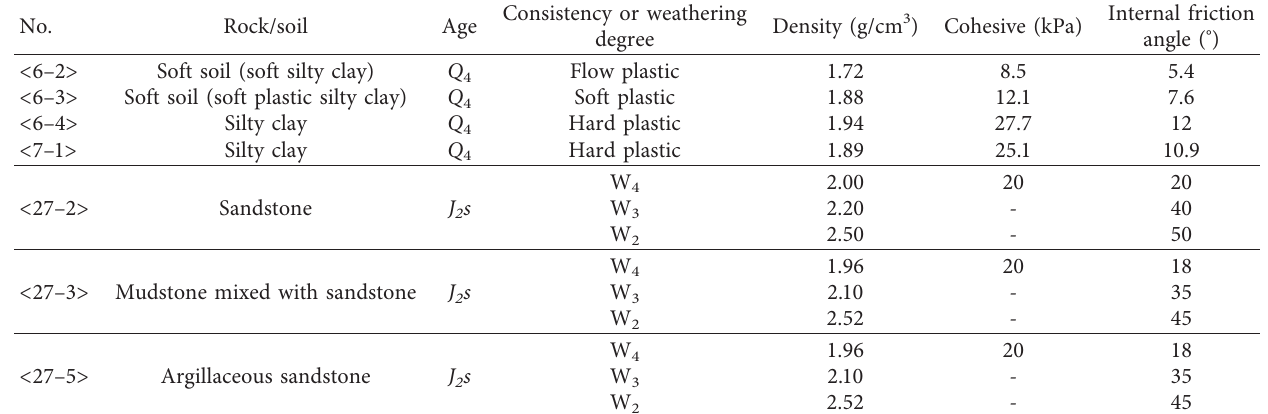
Table 17: Properties of the surrounding rocks.